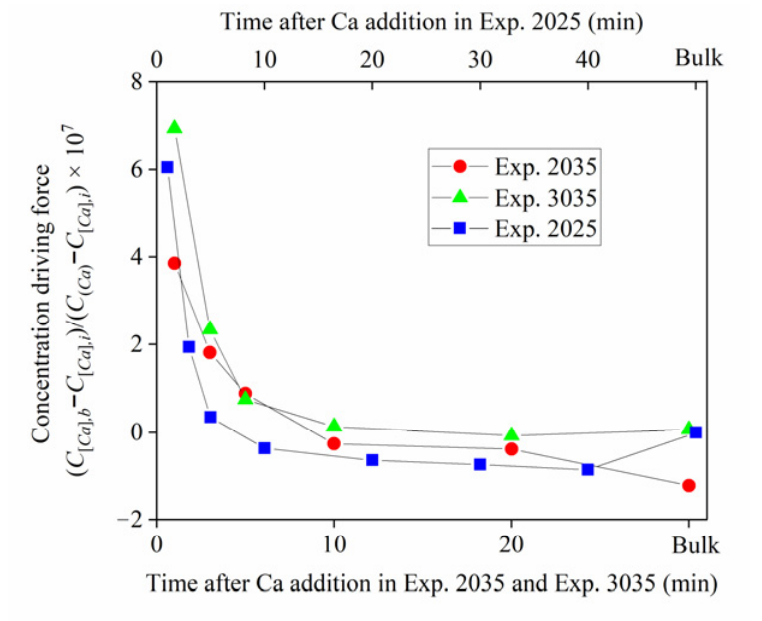
Figure 11. Change of driving force for Ca diffusion in Exp. 2035, Exp 3035, and Exp. 2025.